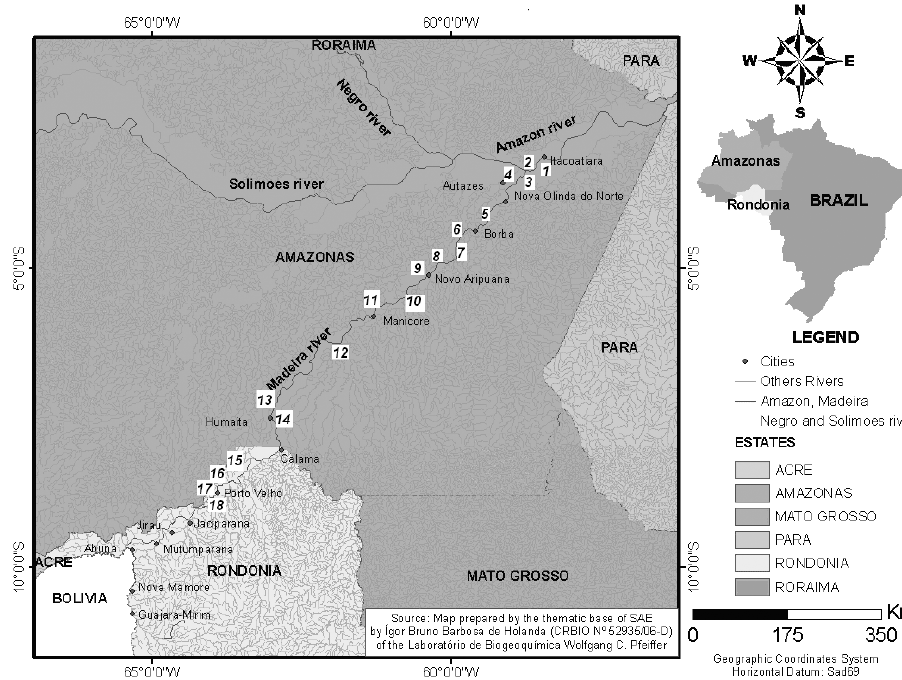
Figure 1. Location of the sampling area along the Madeira River from Porto Velho to the confluence with the Amazon